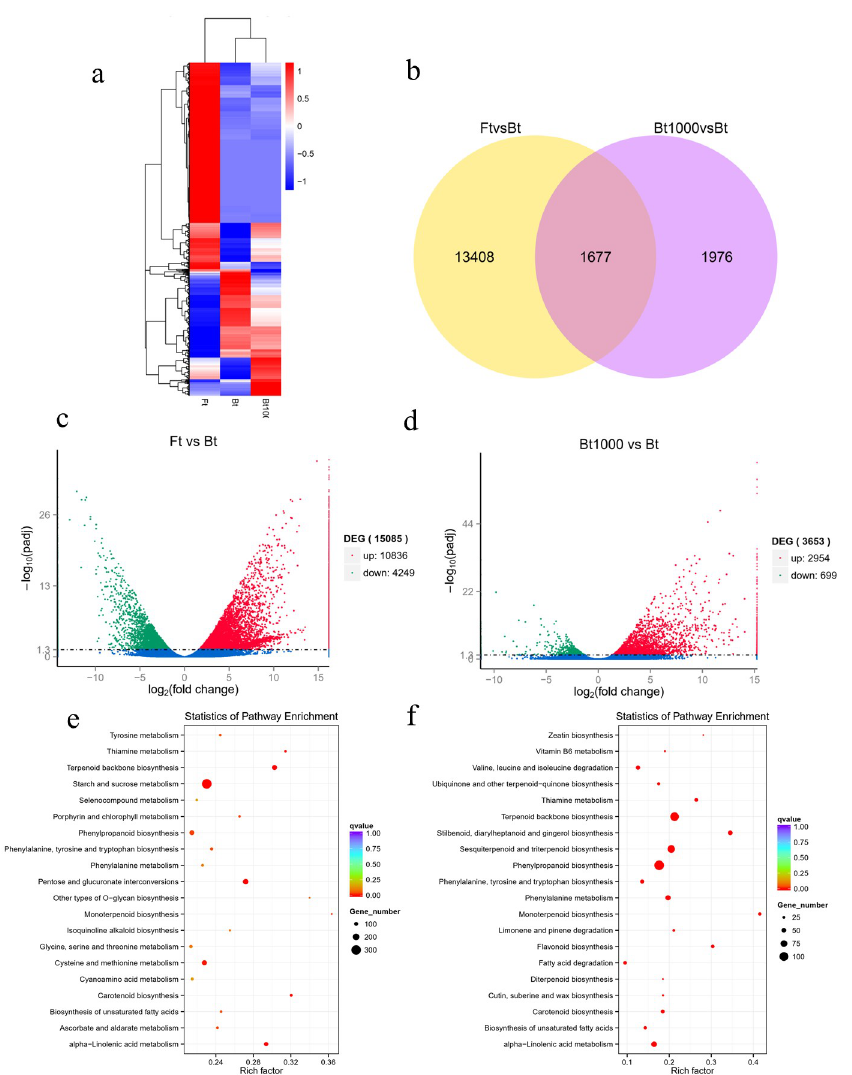
Fig 6. Transcription profiles of Lonicera macranthoides Hand.-Mazz. (a): The cluster heat map for differentially expressed genes (DEGs). (b): Venn diagram showing the distribution of DEGs from Bt, Ft and Bt1000. (c): Volcano plot of differentially expressed genes between Ft and Bt. (d): Volcano plot of differentially expressed genes between Bt1000 and Bt. (e): KEGG enrichment analysis of the differentially accumulated metabolites (DAMs) between Ft and Bt. (e): Kyoto Encyclopedia of Genes and Genomes Ortholog database (KEGG) enrichment analysis of the DAMs between Bt1000 and Bt. Ft indicates the flowering type, Bt indicates closed bud type and Bt1000 indicates MeJA-treated closed bud